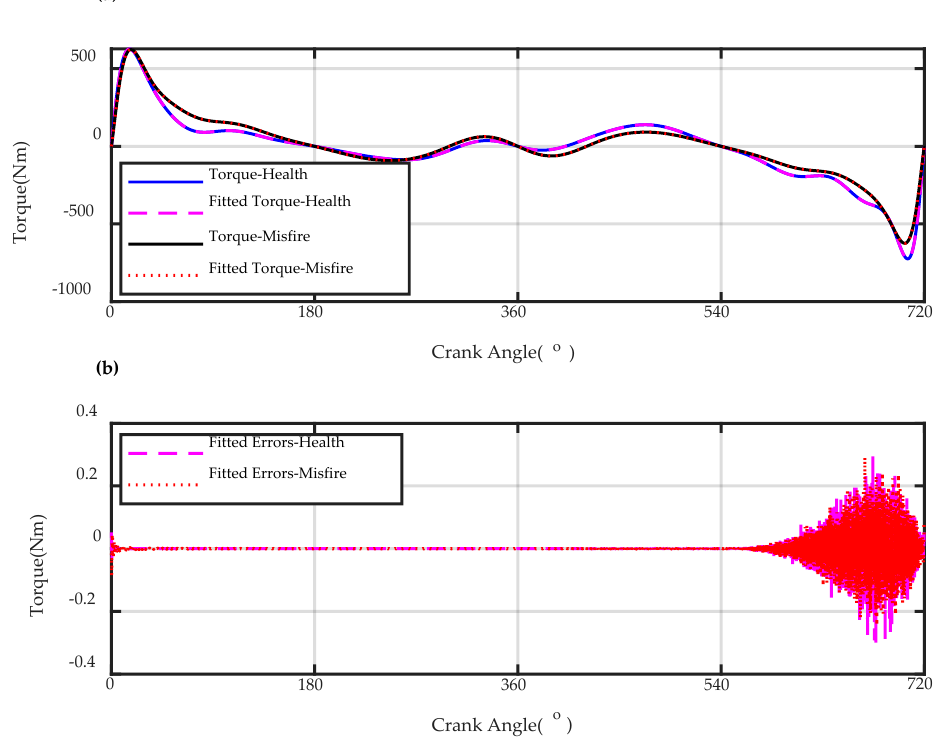
Figure 7. Torque on the crank at health and misfire conditions: ( a ) fitting results; ( b ) fitting errors.